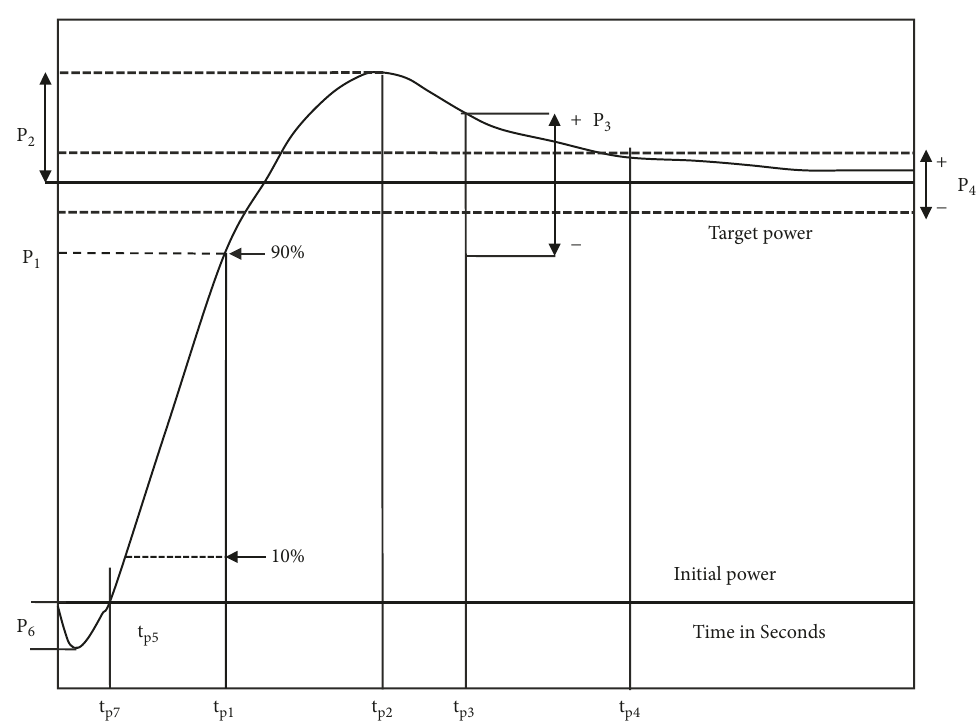
Figure 8: Specifications for a response to a step change in demanded power [1,